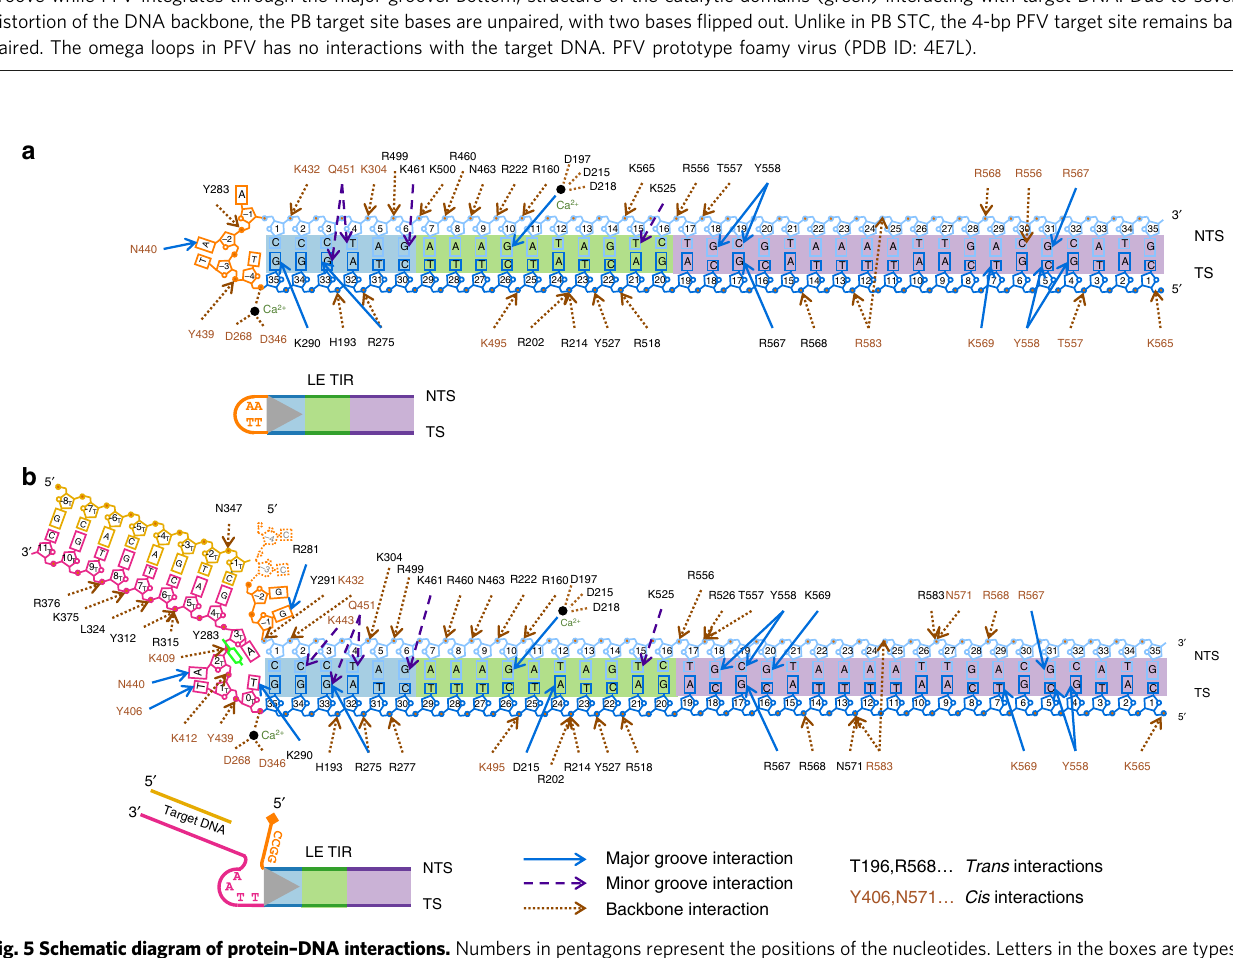
Fig. 5 Schematic diagram of protein – DNA interactions. Numbers in pentagons represent the positions of the nucleotides. Letters in the boxes are types of nucleobases. In the LE TIR hairpin DNA, the nucleotides of the TIR portion (NTS and TS) are from 1 to 35 (5 ′ – 3 ′ ). The hairpin TTAA (orange) is numbered − 4 to − 1 (5 ′ – 3 ′ ). In the strand transfer complex DNA, the TIR portion is numbered the same as in the LE TIR hairpin DNA. Upon integration, the TS strand is covalently joined to the target DNA started from position 0 of the target DNA (0 T ); thus, the bottom strand of the target DNA (pink) is from 0 T to 11 T (5 ′ – 3 ′ ). The top strand of target DNA (yellow) is indicated as − 8 T to − 1 T (5 ′ – 3 ′ ). The fl ap donor DNA (orange, CCGG) is numbered − 4 to − 1 (5 ′ – 3 ′ ), consistent with the hairpin DNA superimposable on T-4, T-3, and A-2 of the hairpin DNA, respectively (Fig. 4d). The major change is with A3 T (equivalent to A-1 in the hairpin loop) which is not fl ipped out but, rather, turned back towards the other target bases and H-bonded through its N1to N3 of T0 T (Figs. 4c, d and 5) and stacked against Y283. To allow the reaction to proceed from the hairpin-bound state to (which becomes the fl ap) is not important in vivo 35,44 . We one poised to capture target, it appears that hairpin resolution is followed by the movement of the resulting fl ap out of the active the side chains of R372 and R376 are inserted into the minor site. Then, a drastically distorted and unpaired target TTAA tet- groove of the fl anking region (A5 T – G8 T , Fig. 5b). ranucleotide can be bound. As the structures reveal, the key to pB transposition is that the backbones of the TTAA tetranucleotide in both the hairpin and target DNA adopt a very similar con- formation (Fig. 4d). The role of the PB protein is therefore to enforce this conformation at both steps of the reaction.